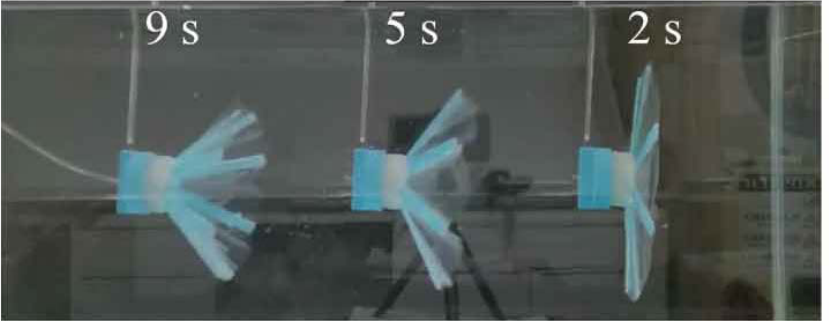
Figure 7. Aquatic robots actuated by vacuum buckling [95] , reproduced with permission from [95], 2021, IOP Publishing Ltd.